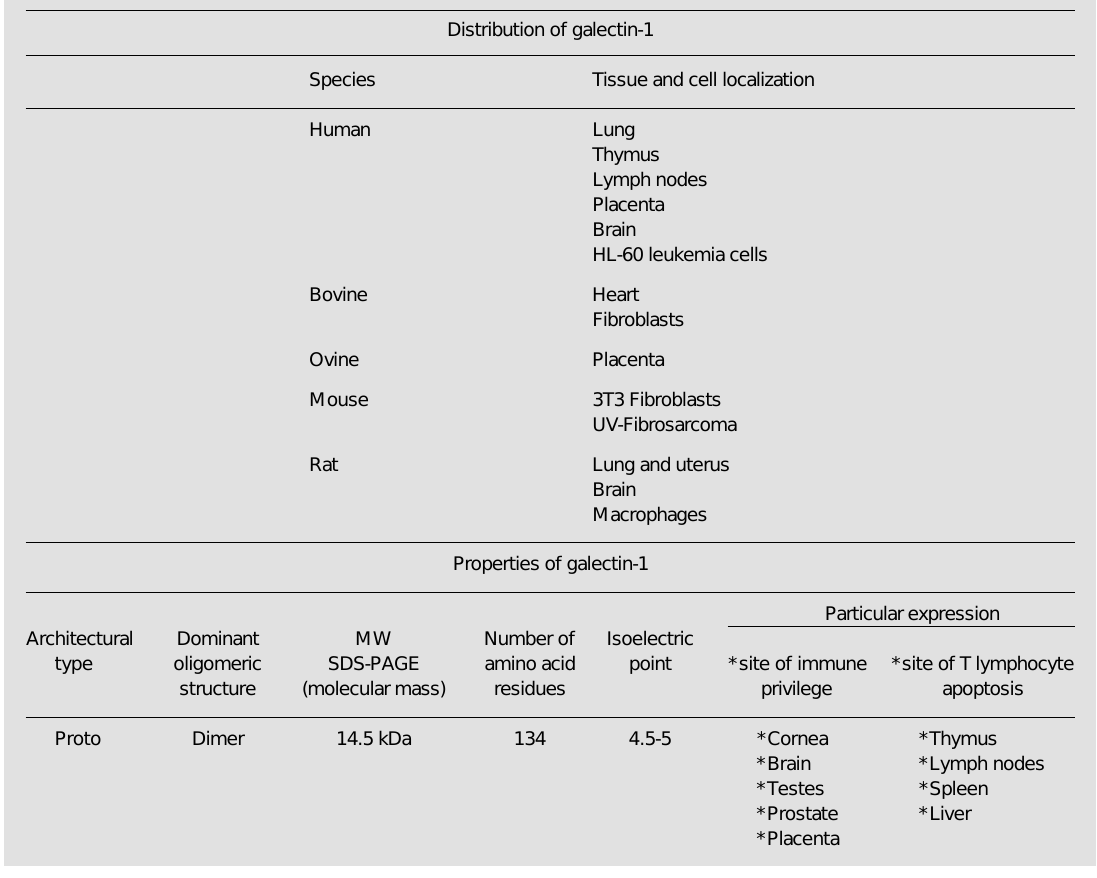
Table 1 - Distributions and properties of galectin-1. Reference 67 summarizes all the members of the galectin family so far